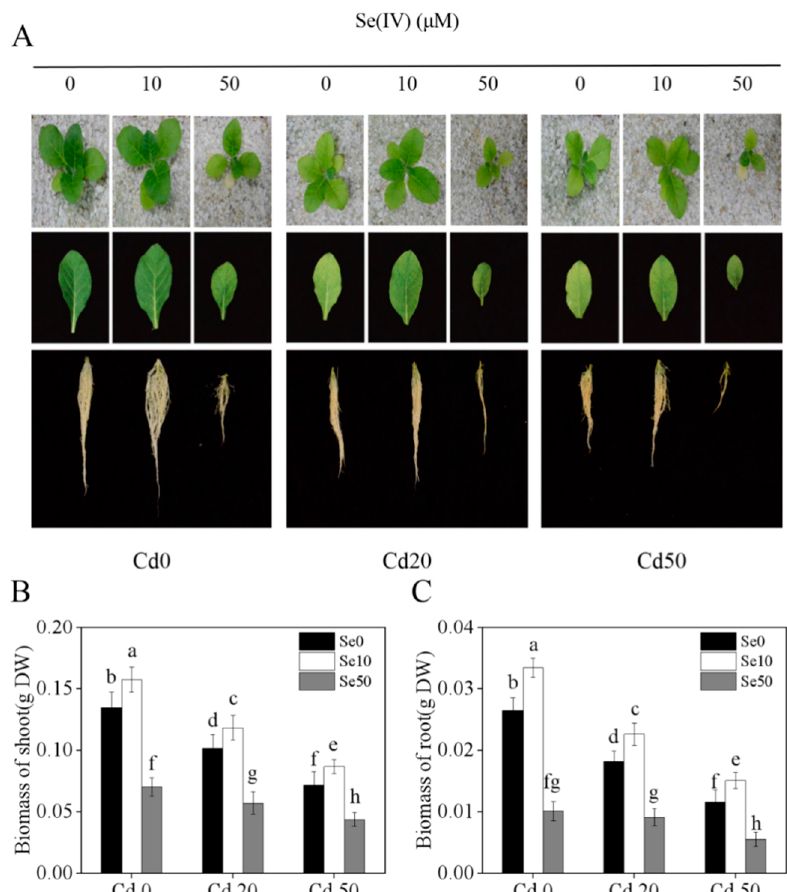
Figure 1. Characterization of tobacco under di ff erent Se and Cd concentration supply conditions for 21 days. ( A ) The phenotype of shoot, third young leaf and root under Se (IV) and Cd (II) treatments in tobacco; ( B ) The biomass of shoot under di ff erent Se (IV) and Cd (II) concentration supply conditions; ( C ) The biomass of root under di ff erent Se (IV) and Cd (II) concentration supply conditions. 14-days-old seedlings (wild-type, Yunyan 87) were grown in pots with sand under di ff erent Se (0, 10, 50 µ M) and Cd (0, 20, 50 µ M) concentrations for 21 days. Se0 : no Se; Se10 : Se, 10 µ M; Se50 : Se, 50 µ M; Cd0: no Cd; Cd20 : Cd, 20 µ M; Cd50 : 50 µ M. Shown are mean ± standard deviation (SD) from five biological replicates. DW, dry weight. Di ff erent letters indicate significant di ff erences ( p < 0.05).